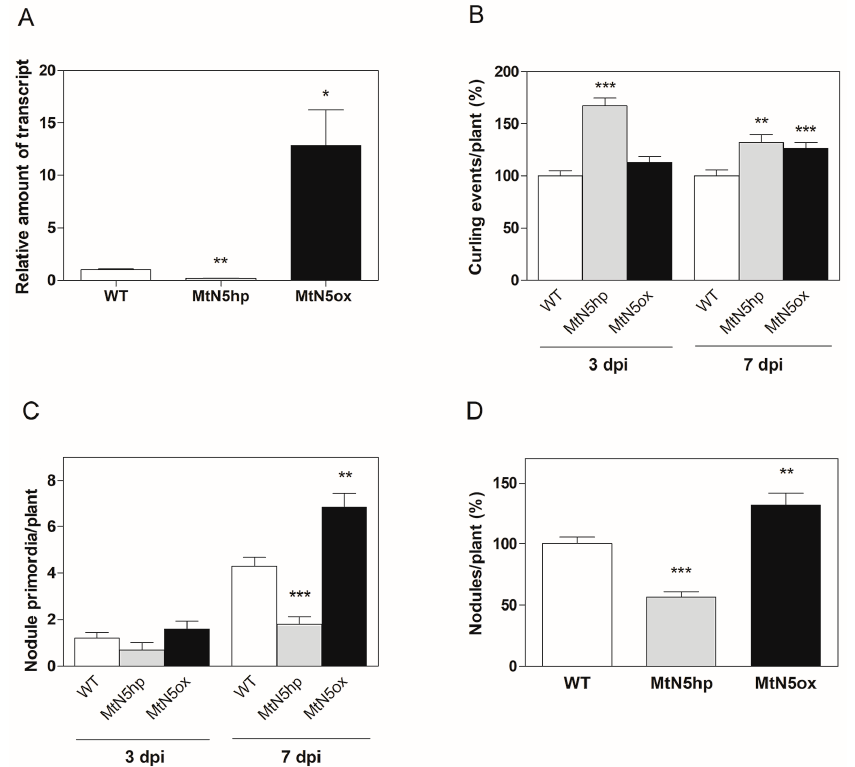
Figure 1. Lipid transfer protein MtN5 gene-silencing and overexpression in Medicago truncatula plants. ( A ) Quantitative Reverse Transcription-PCR (qRT-PCR) analysis of MtN5 mRNA level in leaves of wild type (WT) and stably transformed with the silencing vector MtN5hp and the overexpression vector MtN5ox into plants. The data reported are means ± standard error (SE) ( n = 3). ( B ) Number of root hair curling events per plant and ( C ) number of invaded primordia per plant in MtN5hp and MtN5ox roots inoculated with Sinorhizobium meliloti at 3 days post inoculation (dpi) and at 7 dpi. The data reported in ( B ) was calculated as percentage relatively to WT. The data reported are means ± SE ( n = 10). ( D ) Number of mature nodules per plant in WT, MtN5ox and MtN5hp roots. The data reported are means ± SE ( n = 20) calculated as percentage relatively to WT inoculated roots. Student’s t -test was applied. * p < 0.05; ** p < 0.01; *** p < 0.001.